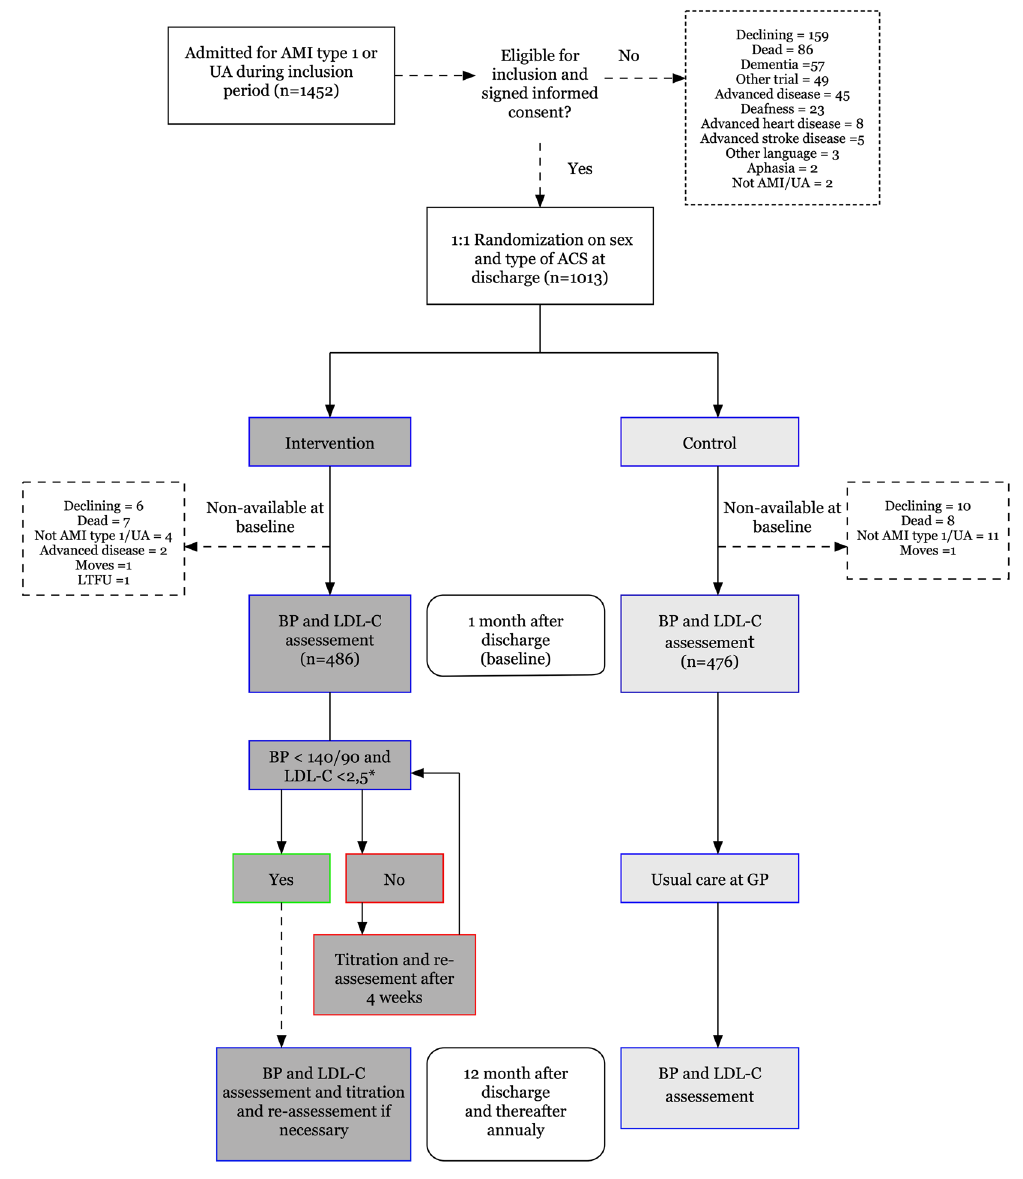
Figure 1. Flow chart of study